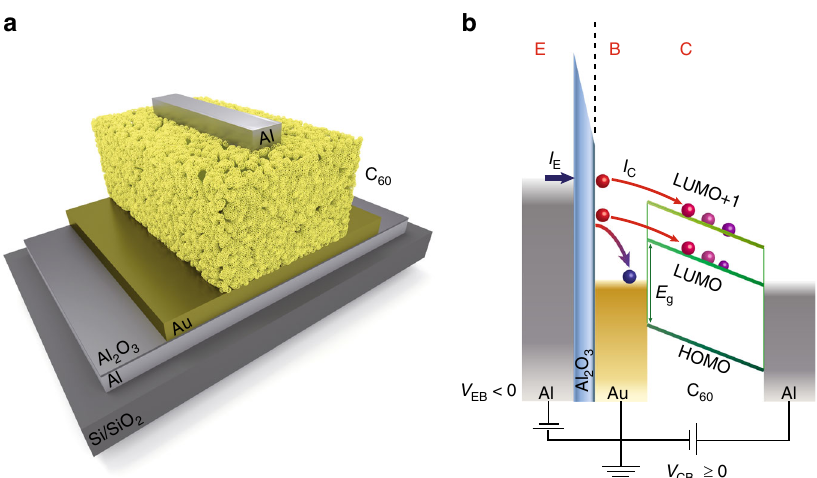
Fig. 1 Device schematics. a Schematic cross section of the device. b Hot-electron transistor operation. Electrons are injected by applying a negative emitter-base bias, V EB < 0V, and detected in the molecular semiconductor. These electrons are out of equilibrium with the thermal electrons in the base which cannot be described by a larger temperature. The measurements can be performed either without any externally applied collector-base bias, V CB , or by V CB ≥